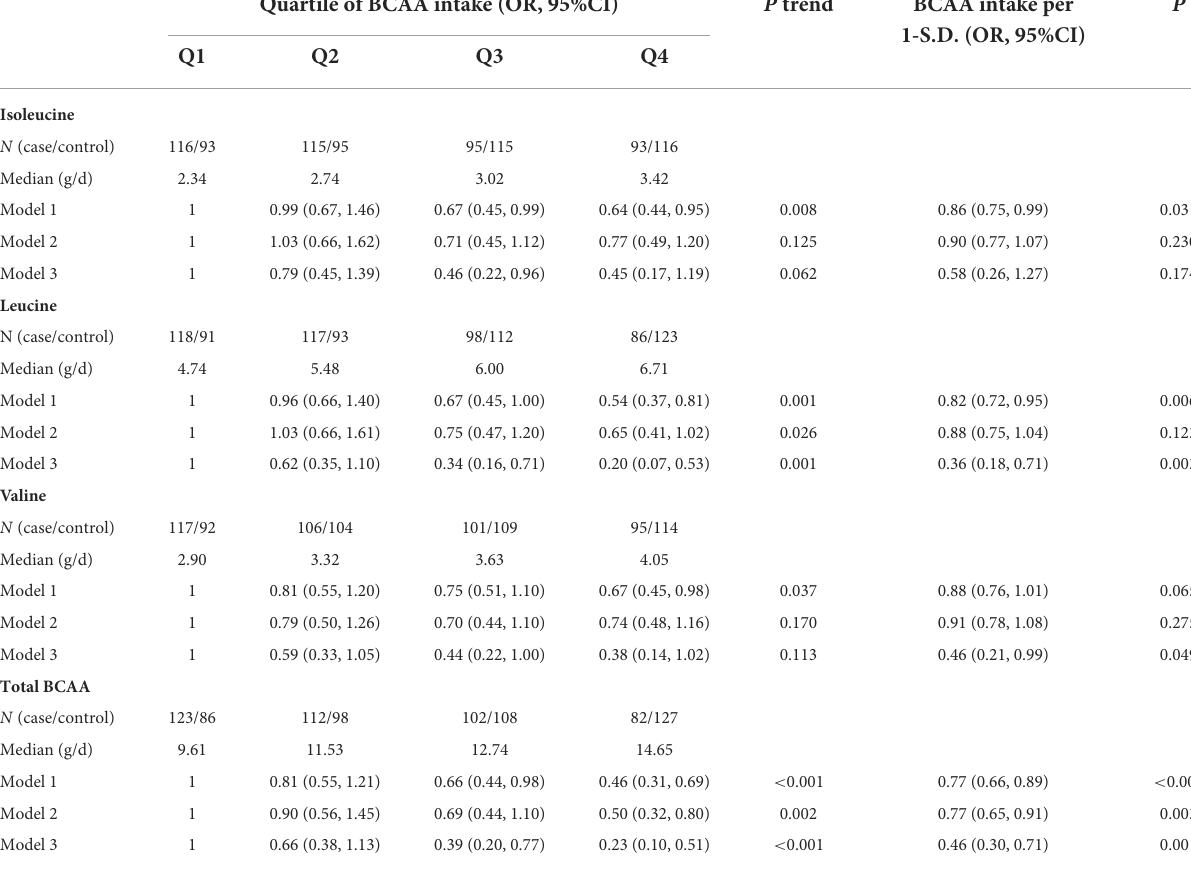
TABLE 6 Odd ratios and corresponding 95% confidence intervals according to dietary BCAA intake and the risk of CVD in type 2 diabetes individuals. Quartile of BCAA intake (OR, 95%CI) P